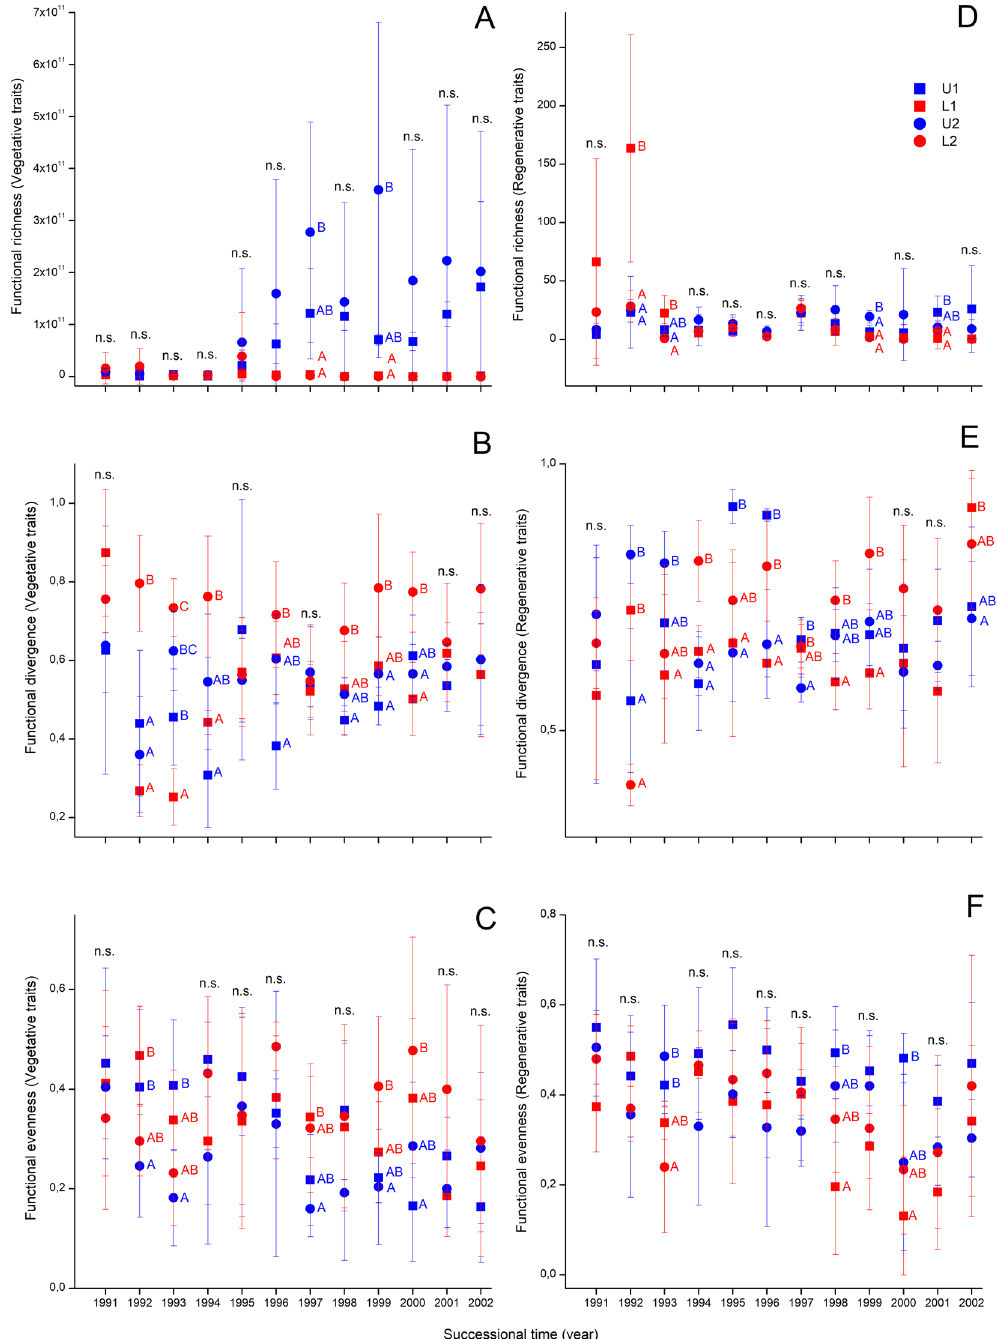
Figure 4. Temporal change of multi-trait indices of functional richness (FRich), functional divergence (FDiv) and functional evenness (FEve) for the vegetative (on the left) and regenerative traits (on the rigth). Notations: rectangle – sites at the eastern part of the reserve; circle – sites in the western part of the reserve; blue – sites laying near to the dune top; red – sites laying near to the dune slack. Significant differences were indicated by superscript letters (Univariate GLM and Tukey